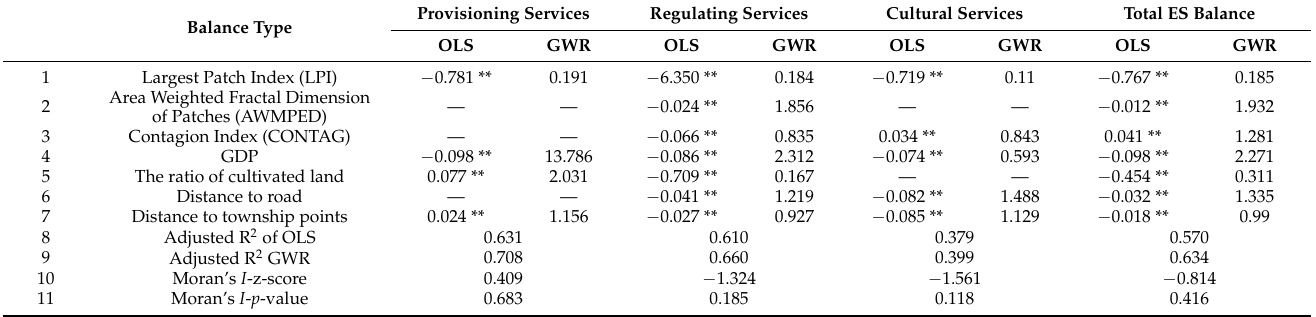
Table 1. Parameters and test results of OLS and